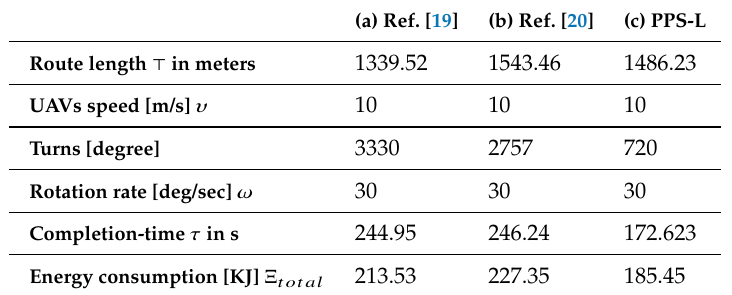
Table 7. CPP path provided in Ref. [30] and Ref. [20] vs. our CPP using our PPS-L partition